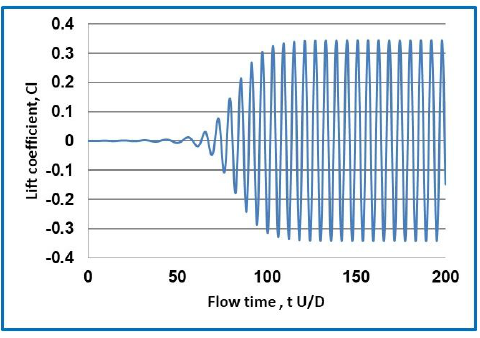
Figure 3: Drag coeflcient history of the fixed cylinder at Re = 100